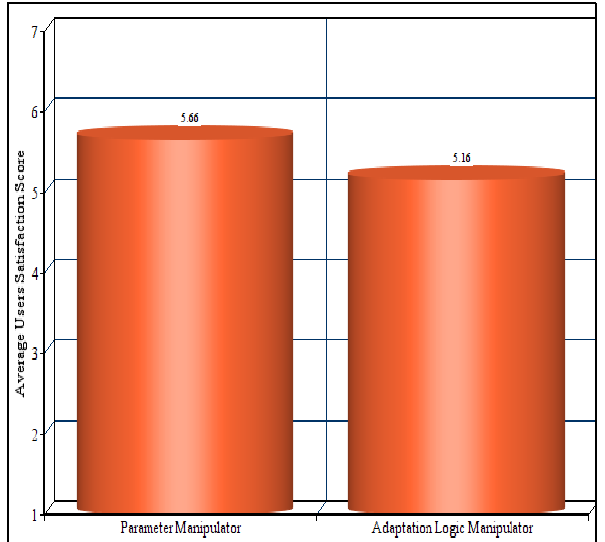
Figure 6. Users Satisfaction Score for User Control Manager